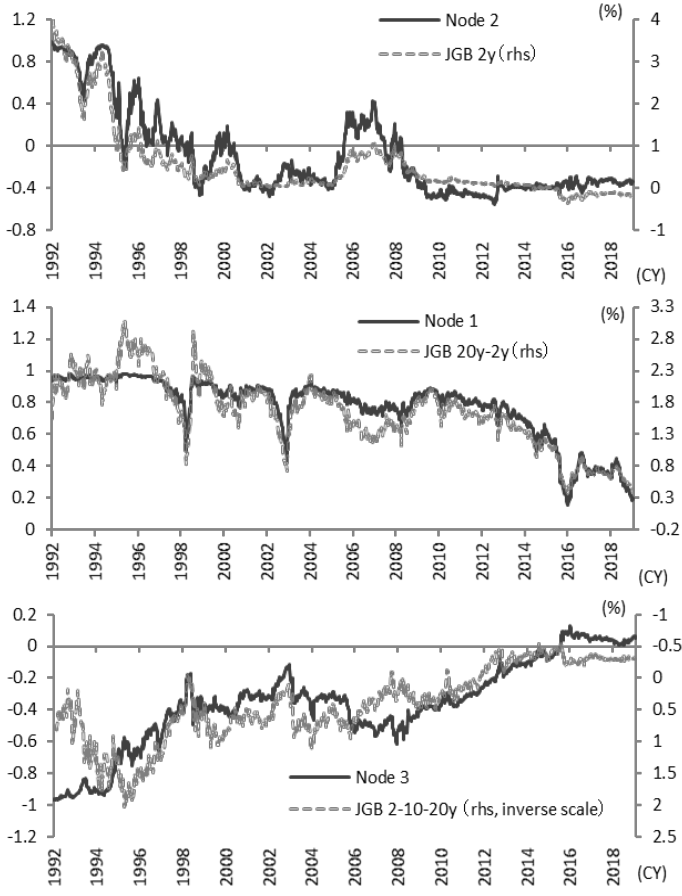
Figure 8. Plots of the hidden layer node output with the corresponding interest rate levels and interest rate spread.